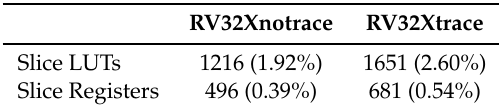
Table 5. Resources used on the implementation of the CPU with and without the presented